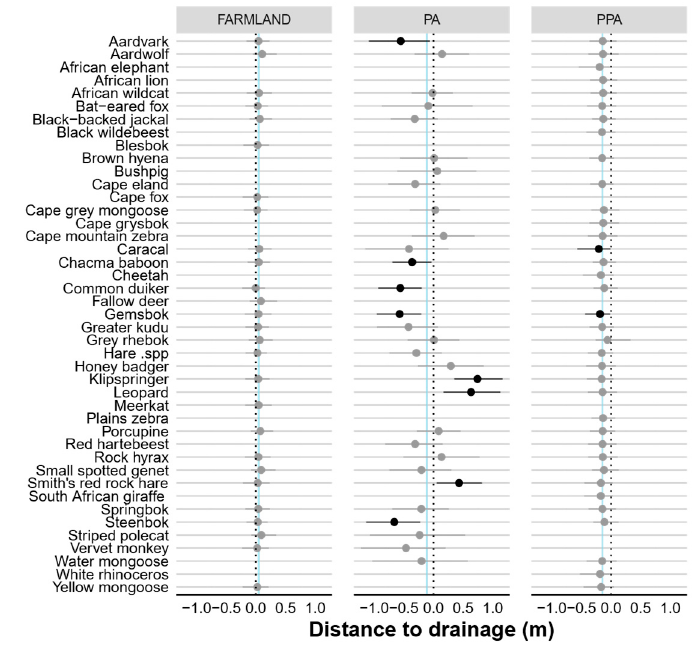
Figure A4. Caterpillar plots showing the standardised beta coefficients and 95% Bayesian credible intervals for the influence of distance to drainage (m) on the occurrence probability ( Ψ ) of each species in the farmland, PA and PPA. Confidence intervals in bold do not overlap 0 (dashed line), indicating significant predictors of detection. Vertical blue lines indicate community means.